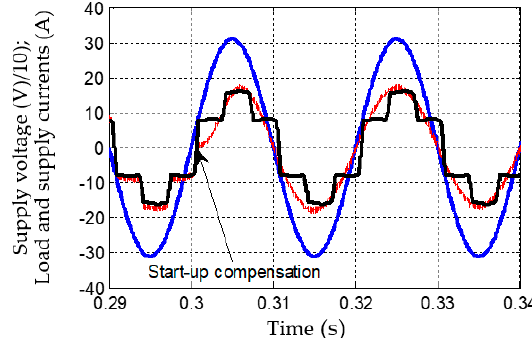
Figure 11. Waveforms of load current (in black), supply voltage (in blue) and supply current (in red) during the start-up of the compensation.